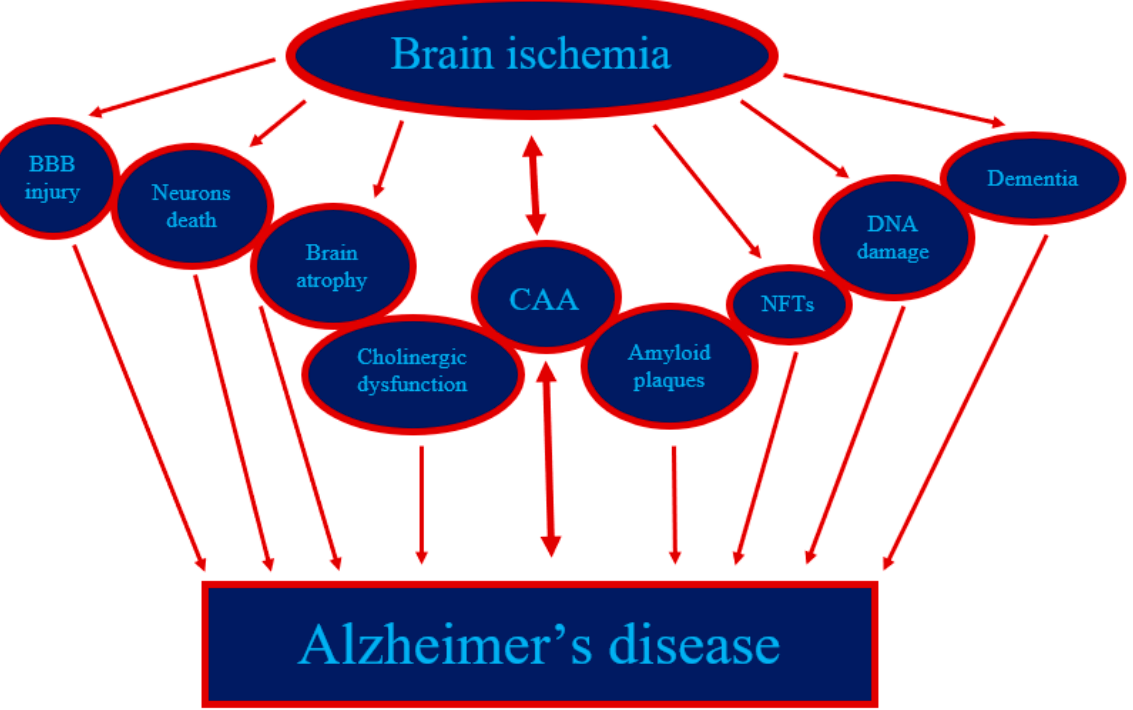
Figure 2. The events in post-ischemic brain injury have a remarkable parallel with Alzheimer’s dis- ease. BBB—blood–brain barrier; CAA—cerebral amyloid angiopathy; NFTs—neurofibrillary tan- gles.